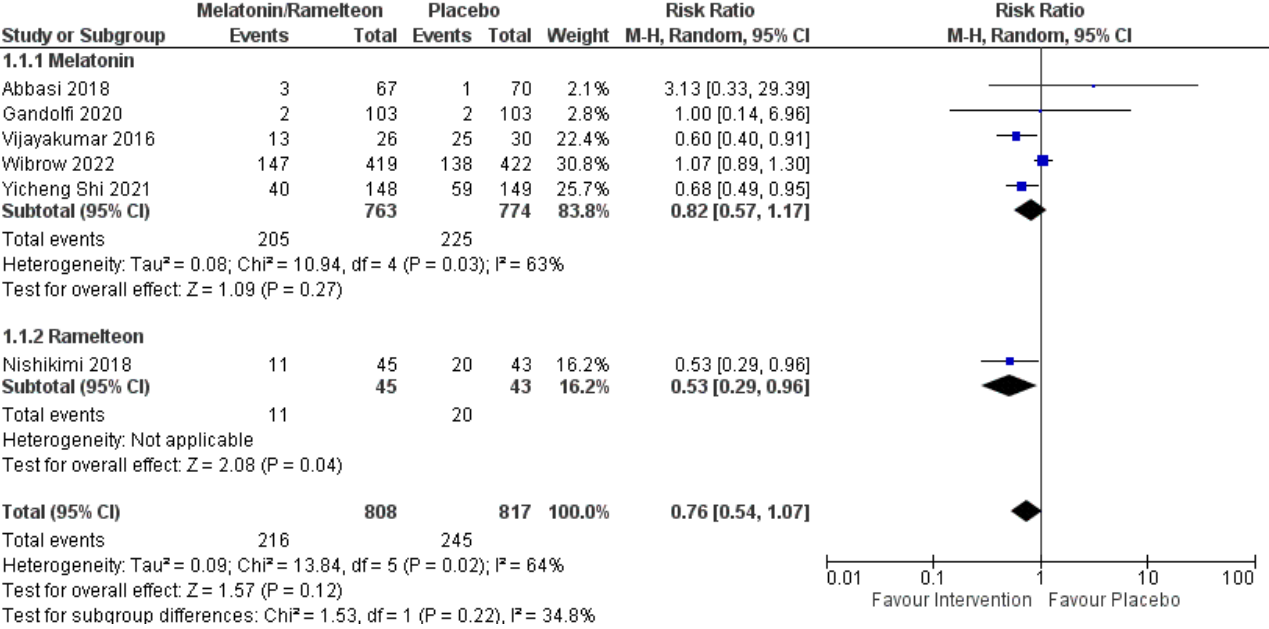
Figure 1. Forest plot reporting the differences in delirium incidence in patients admitted in the in ‐ tensive care unit and treated with melatonin or ramelteon as compared to a placebo. Abbreviations: CI, confidence interval; M ‐ H, Mantel–Haenszel. (Abbasi et al. [20]), (Gandolfi et al. [23]), (Vijaya